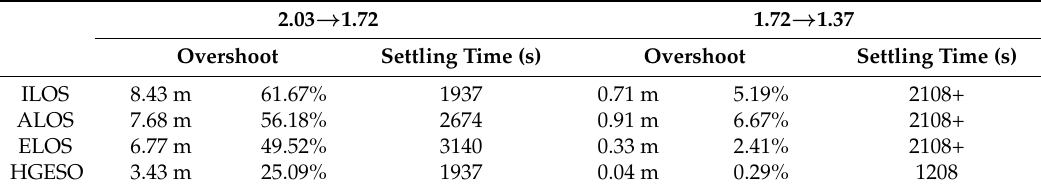
Table 2. Comparison of overshoot and settling time at y d = 0.1 L .